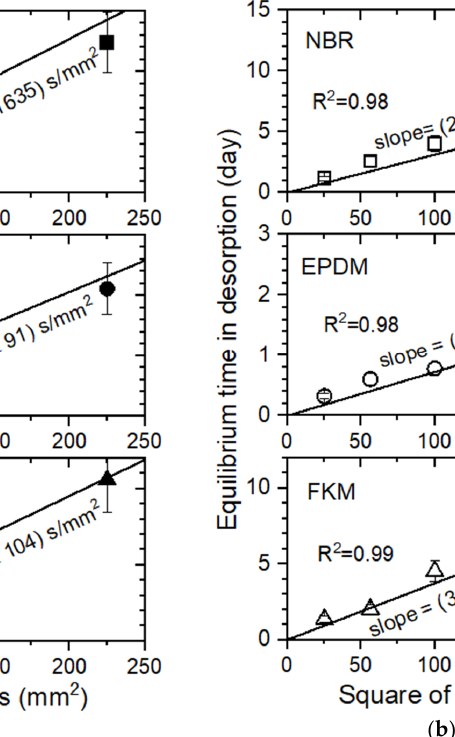
916,246 s for 30 mm diameters. The desorption equilibrium times (blue arrow) obtained for the FKM were 116,399 s for 10 mm, 173,434 s for 15 mm, 389,143 s for 20 mm, and 690,849 s for 30 mm diameters.